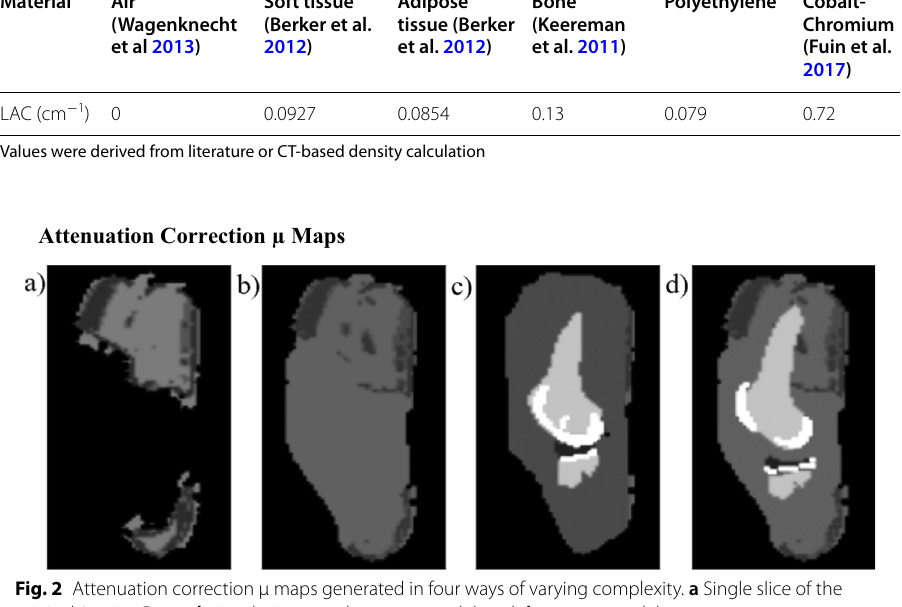
Table 2 LAC values used to construct the segmentation-based µ map LAC values of tissue and implant components Material